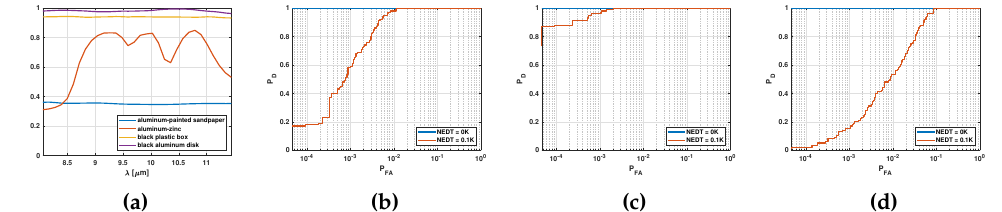
Figure 1. ROC curves: ( a ) spectral emissivities of the materials ( b ) aluminum-painted sandpaper; ( c ) black aluminum disk; ( d ) black plastic